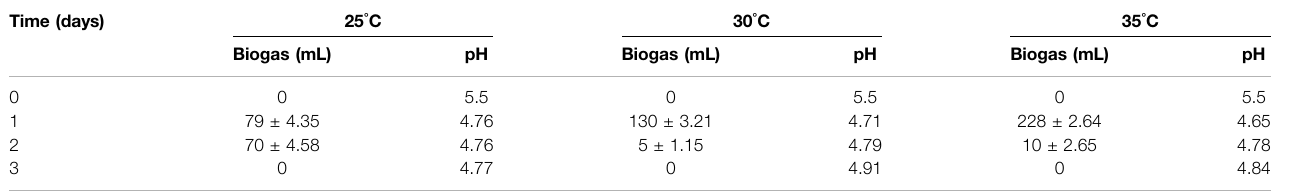
TABLE 3 | In fl uence of temperature on the performance of the fi rst stage of anaerobic digester of TS-AD Time (days)